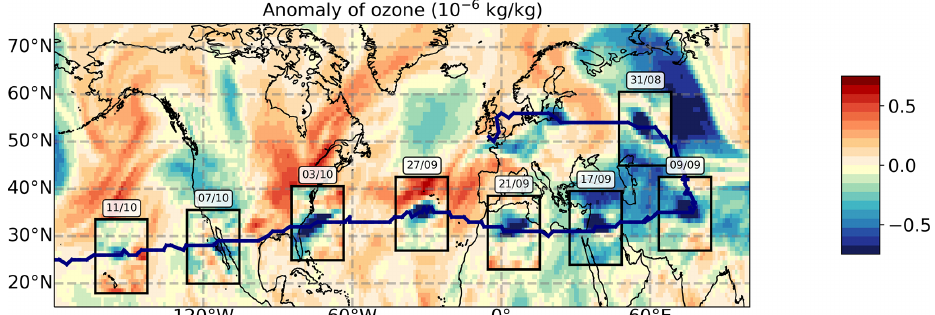
Figure 6. Sequence of ozone anomalies along the trajectory of vortex A for selected dates from 31 August to 11 October. The background is the mean ozone anomaly over this period at 460K. For each selected day, the box shows the ozone anomaly on that day at 00:00UTC at the level of the vortex centroid according the ozone anomaly tracking, reported along the blue line.